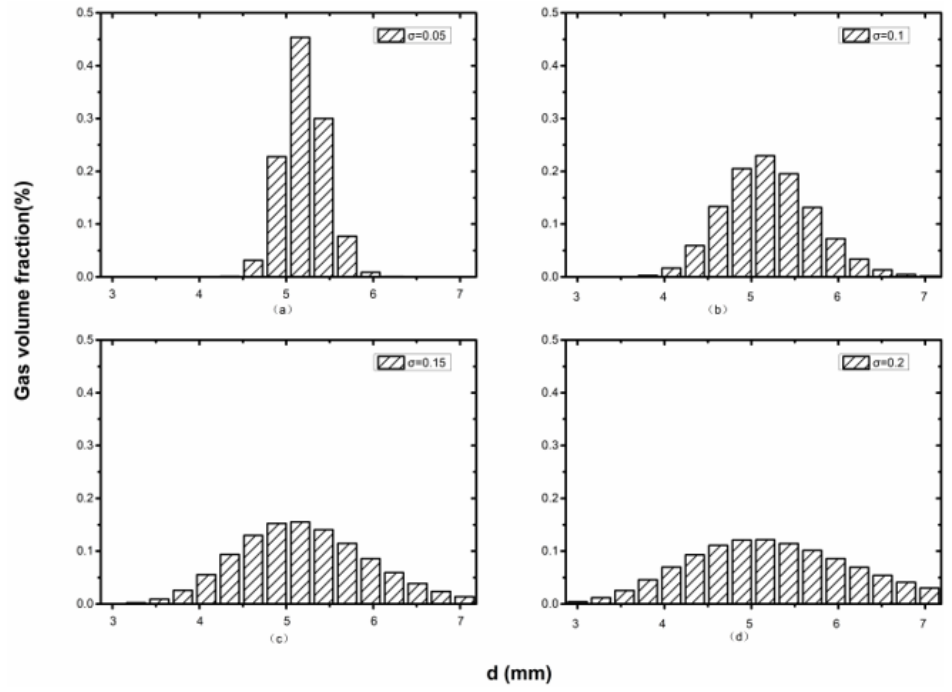
Figure 11. Histogram of bubble diameter distribution with different standard deviations.( a ) σ = 0.05; ( b ) σ = 0.1; ( c ) σ = 0.15; ( d ) σ =